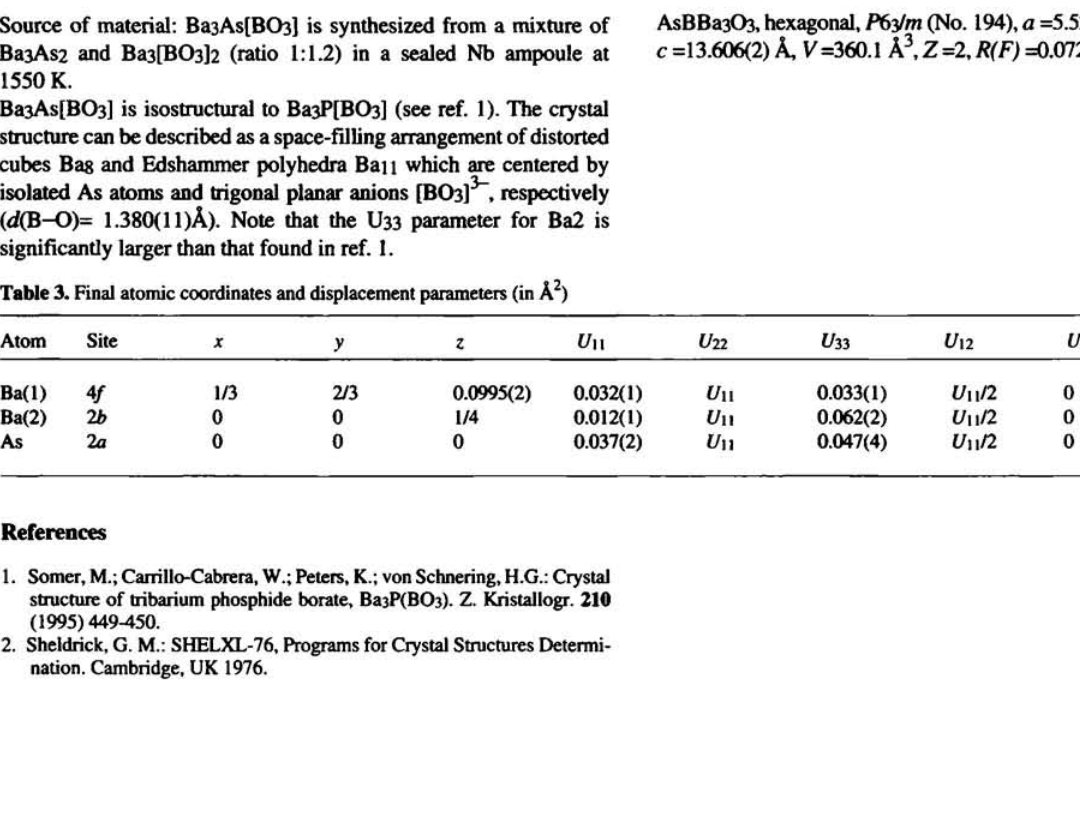
Table 2. Final atomic coordinates and displacement parameters (in Â 2 )